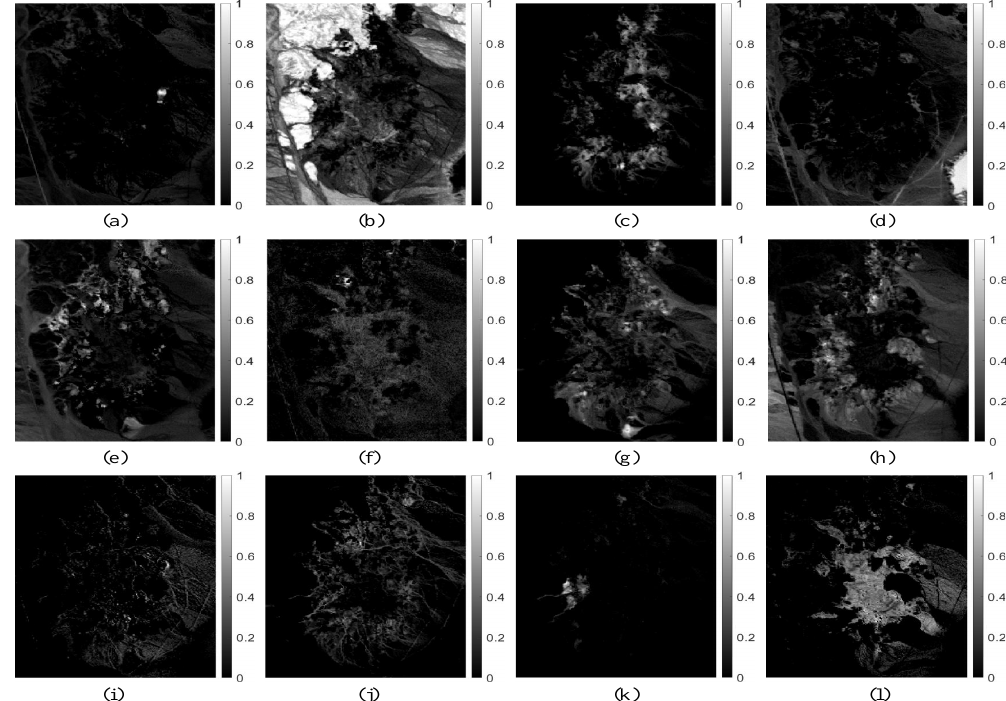
Figure 6. Abundance fraction maps estimated by our MDA-MVSA method from the Cuprite subimage: ( a ) Chlorapatite WS423; ( b ) Jarosite WS368 Pb; ( c ) Montmorillonite SCa-2.a; ( d ) Kaolin/Smect KLF511 12%K #1; ( e ) Kaolin/Smect KLF508 85%K; ( f ) Nontronite NG-1.a; ( g ) Montmorillonite SCa-2.b; ( h ) Nontronite SWa-1.a; ( i ) Kaolin/Smect KLF511 12%K #2; ( j ) Kaolin/Smect H89-FR-5 30K; ( k ) Buddingtonite GDS85 D-206; and, ( l ) Kaolin/Smect KLF511 12%K